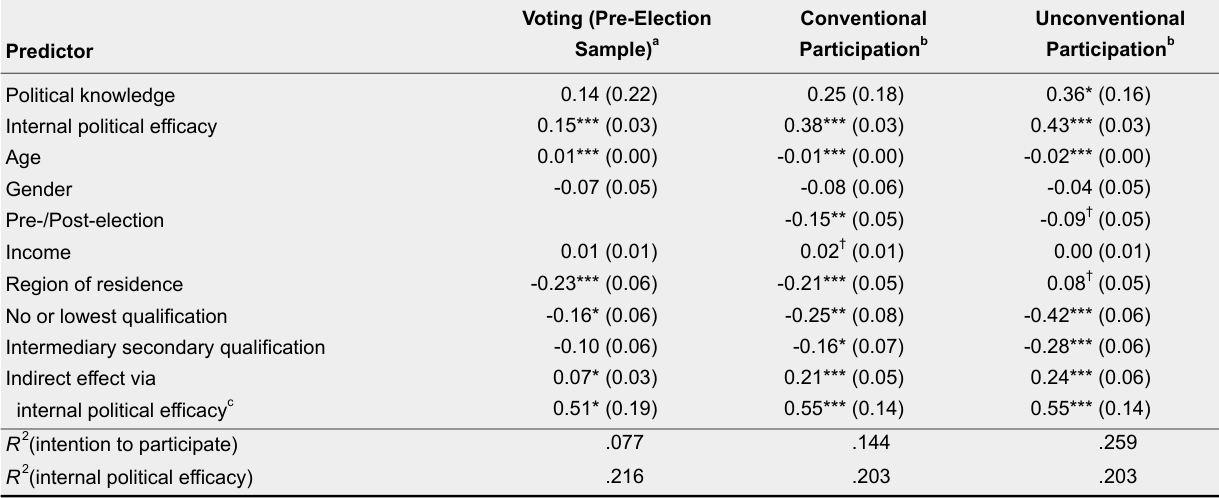
Cross-Sectional Mediated Regression Analyses (Criteria: Intentions to